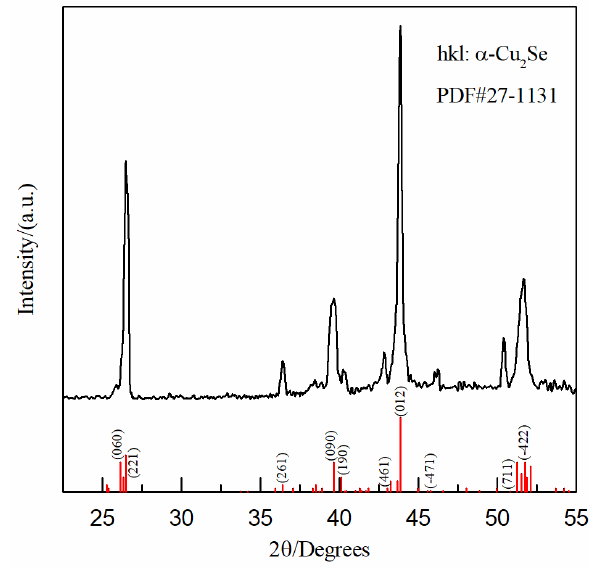
Figure 8. XRD pattern of Cu-Se film as-deposited. The Cu-Se thin films were peeled off from copper substrate with high-temperature resistant epoxy adhesive, and thermoelectric properties were analyzed after annealing.